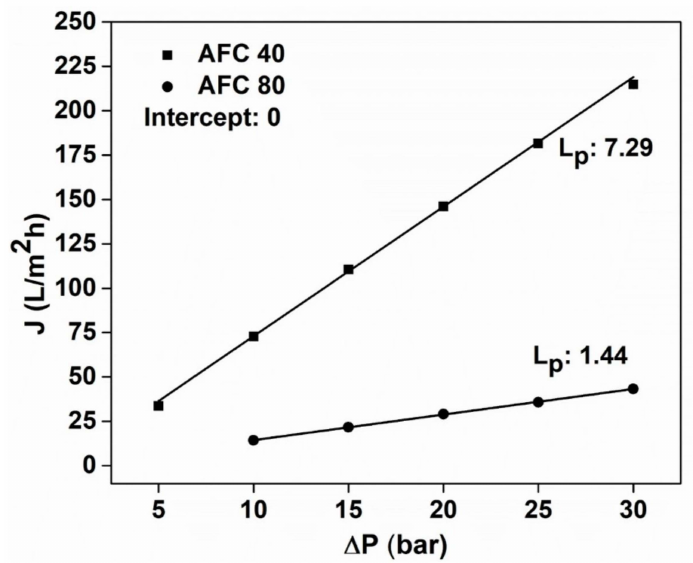
Figure 2. Distilled water flux of the AFC 40 and AFC 80 membranes at different operating transmem- brane